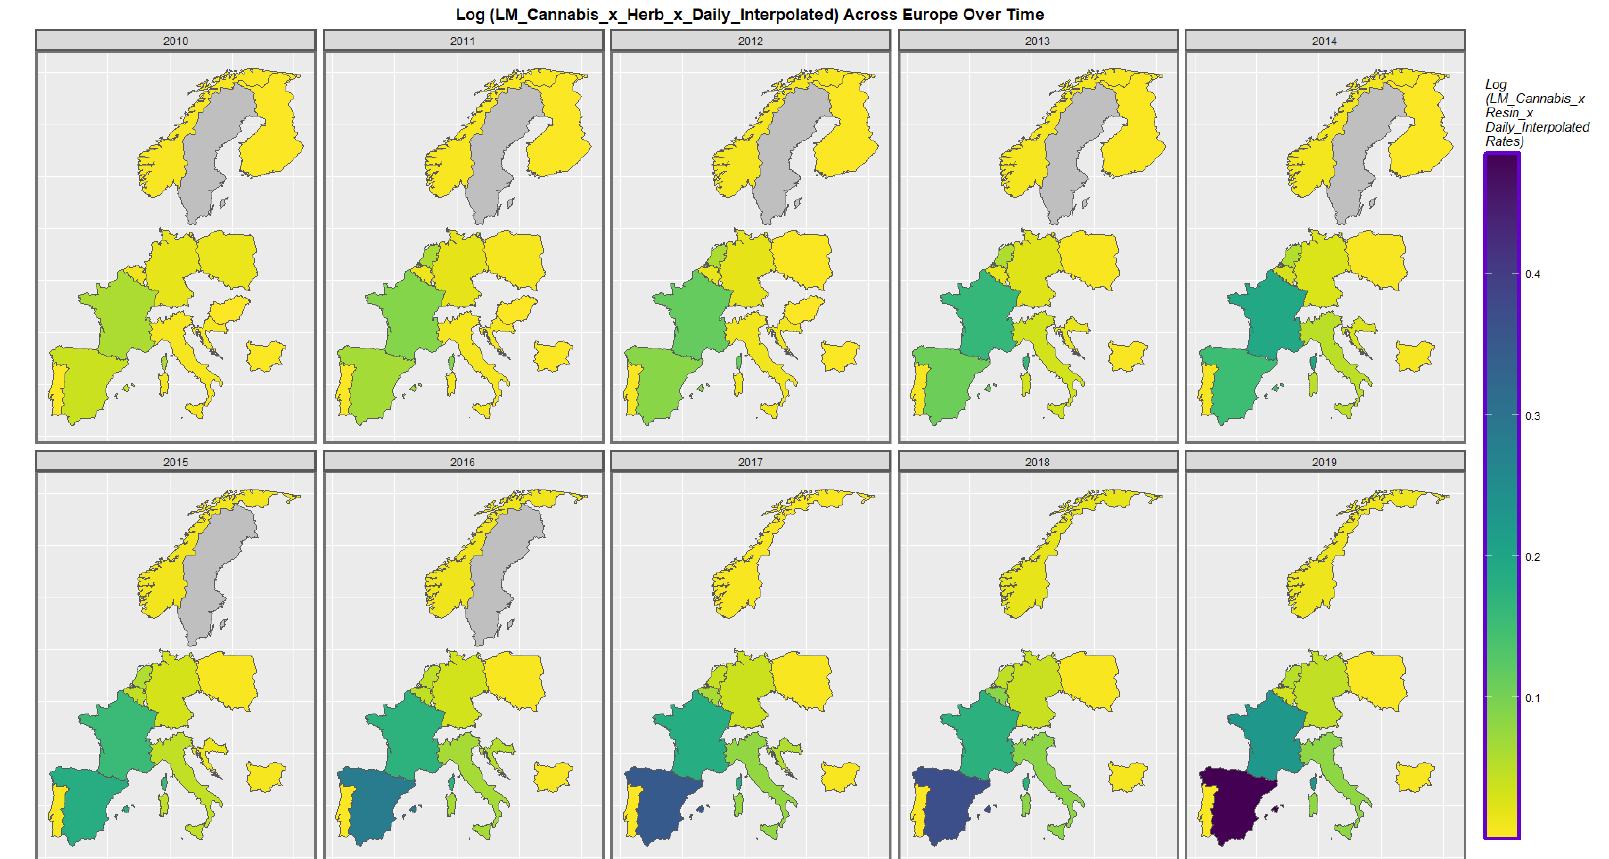
Figure 5. Sequential map-graph of last month cannabis use: cannabis herb THC concentration: daily cannabis use interpolated over time in selected European nations 2010–2019.